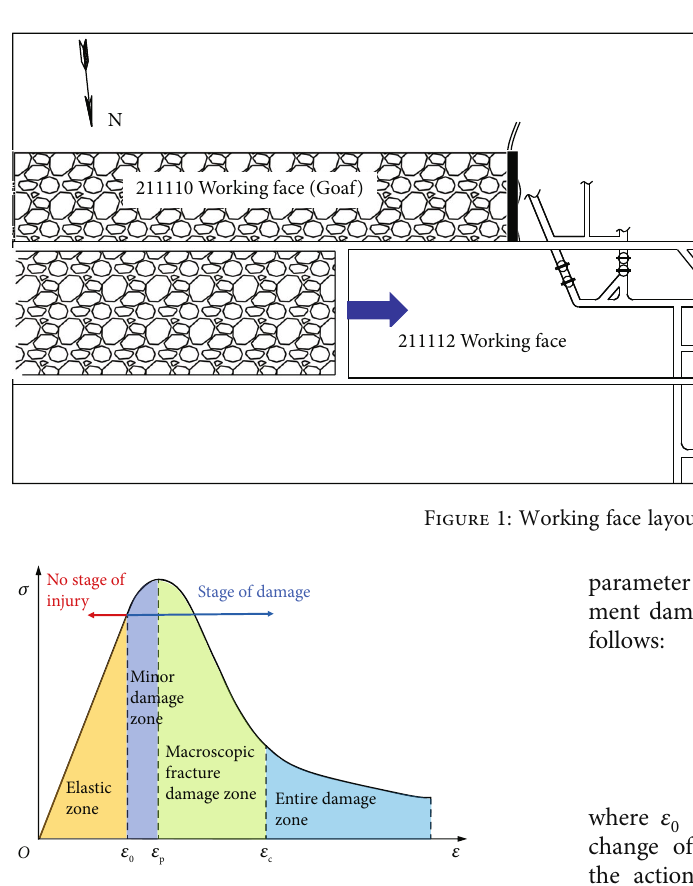
Figure 2: Schematic diagram of rock damage